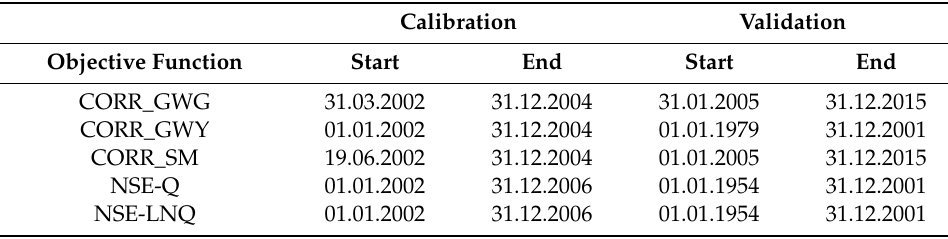
Table 4. The model calibration and validation